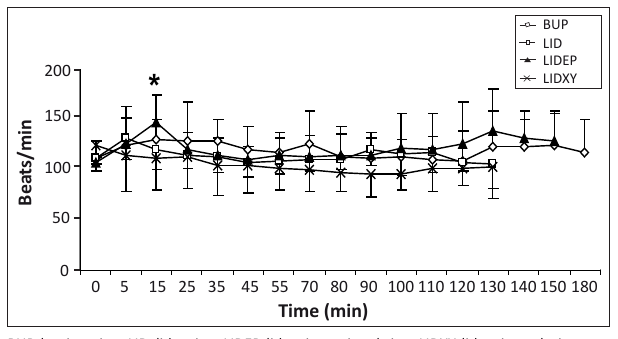
FIGURE 2: Heart rate (mean ± s.d.) in sheep ( n = 6) administered with epidural lidocaine, lidocaine-epinephrine, lidocaine-xylazine or bupivacaine.